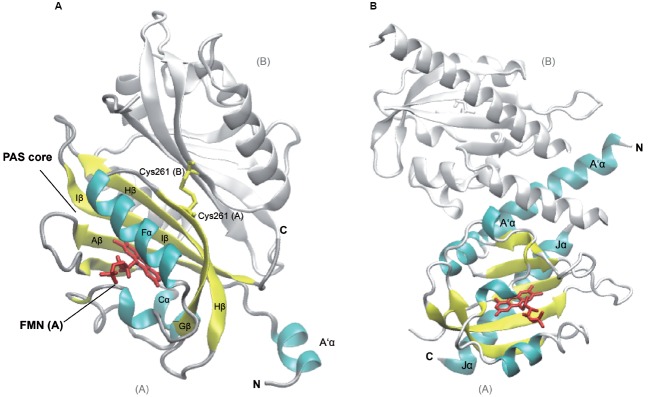
Structures of Arabidopsis thaliana LOV1 and LOV2 domains of phototropin 1 dark-adapted state. LOV1 domain (2Z6C; Nakasako et al., 2008), (A) and LOV2 of phototropin 1 in dark-adapted state (4HHD; Halavaty and Moffat, 2013), (B). Subunits B of LOV1 and LOV2 are shown in white, subunit A of the respective LOV domains is shown in colors according to secondary structure. Several α-helices (cyan) and β-strands (yellow) of the PAS core are labeled according to their nomenclature within the PAS domain as well as flanking helices, which are involved in dimerization and signaling. The Flavin mononucleotide chromophores (red) and the disulfide-bond-creating Cys at position 261 (Cys261, yellow) in the monomers of LOV2 domains, respectively, are depicted as sticks. C- and N-termini of subunits A and B are labeled (C, N). The graphic representation of the structure was generated using VMD (Humphrey et al., 1996).